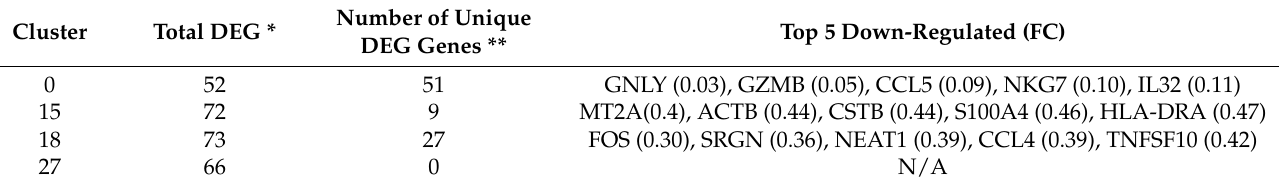
Table 8. Down-regulated DEG in clusters identified as M1